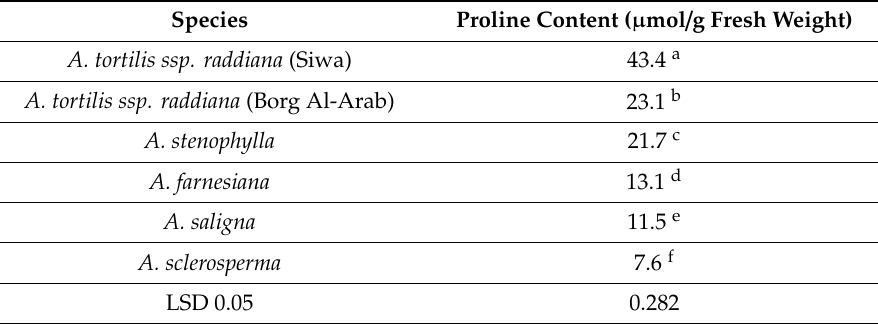
Table 3. Proline content ( µ mol / g fresh weight) in some Acacia species.